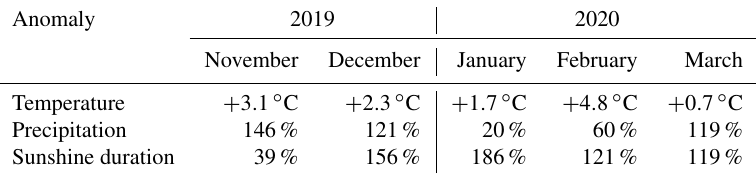
Table 1. Monthly meteorological anomalies relative to reference long-term averages of the 1981–2010 period.